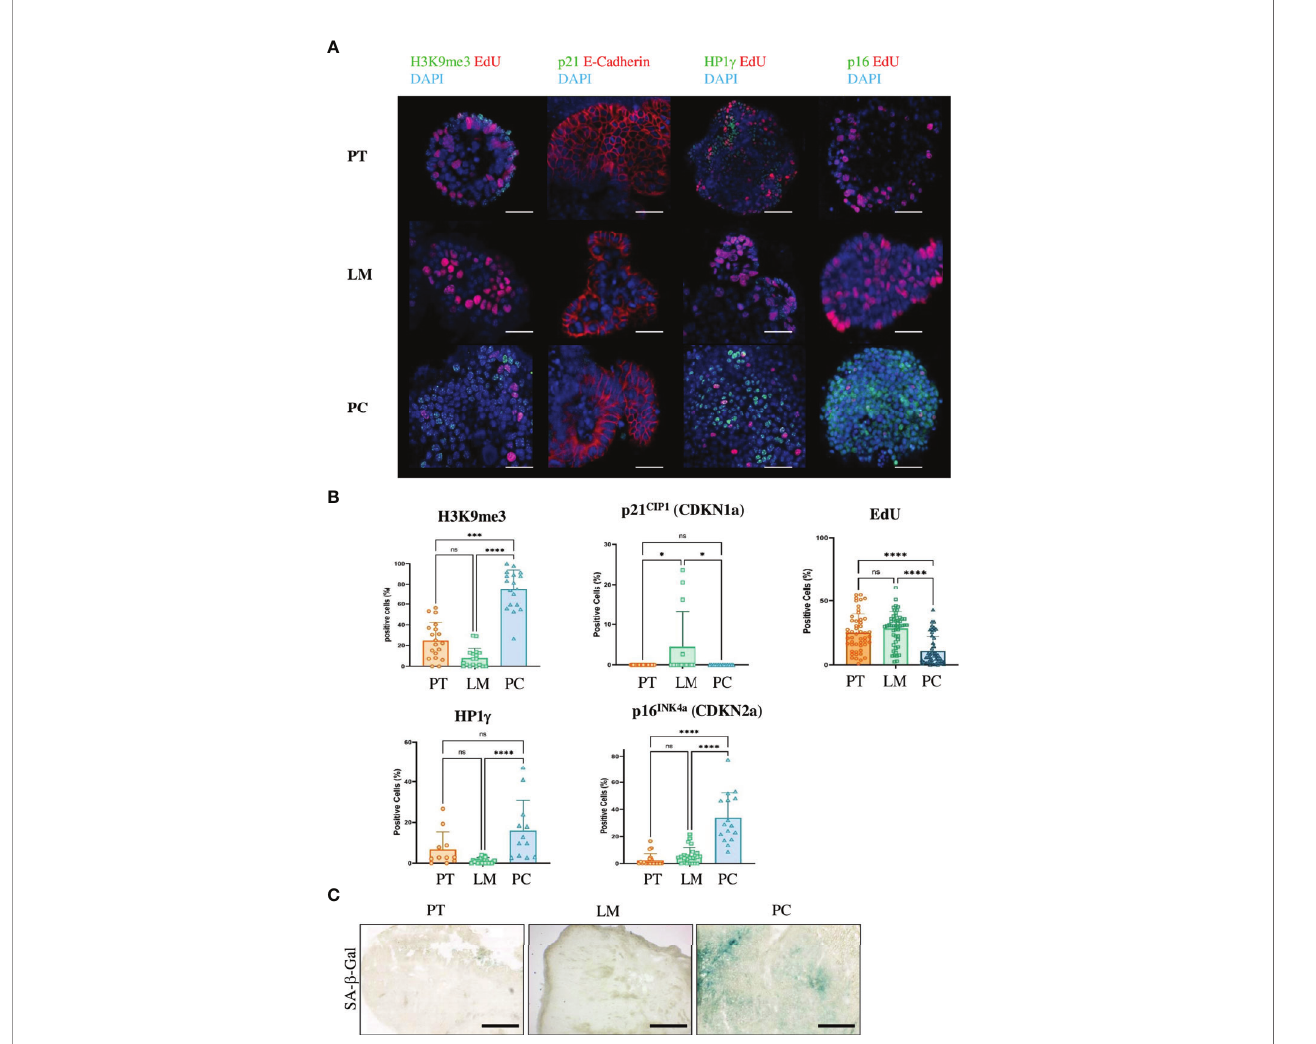
FIGURE 3 | Only cancer cells from metastases in the peritoneal cavity of the APTAK mouse model show a senescent phenotype. (A) Representative immuno fl uorescence (IF) images of the senescence-associated markers H3K9me3, p21 CIP1 , HP1 g and p16 INK4a (all green) from organoids derived from primary tumors (PT), liver metastases (LM) and PC from the orthotopic organoid transplantation CRC mouse model. The proliferation marker EdU was stained in red and nuclei were stained in blue. p21 was combined with the cell membrane-bound E-Cadherin (red) and not with EdU. Scale bars represent 50 µm. (B) Quanti fi cation of IF markers per group derived from primary tumors (n = 5 mice), liver metastases (n = 3 mice) and PC (n = 3 mice) from the orthotopic organoid transplantation CRC mouse model. 3-5 HPF per mouse and marker with at least 1000 APTAK cancer cells were analyzed. Error bars represent the mean ± SD. Kruskal-Wallis test (B) ****p < 0.0001, ***p < 0.0002, *p<0.05, n.s. = not signi fi cant. (C) Representative images of SA- b -gal from primary tumors (PT), liver metastasis (LM) and peritoneal carcinomatosis (PC) from a mouse of the orthotopic organoid mouse CRC model. n = 5 mice per group. Scale bars represent 1000